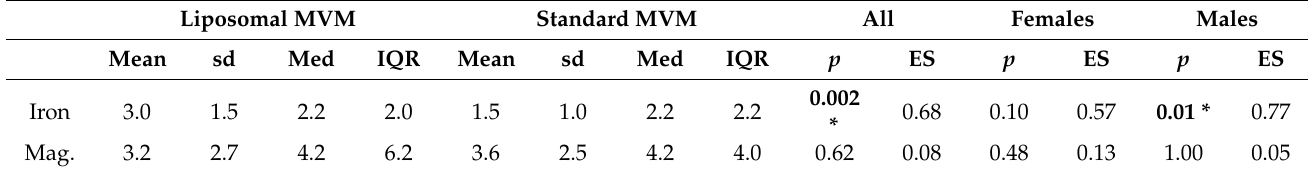
Table 6. Time of maximal observed concentration (Tmax)